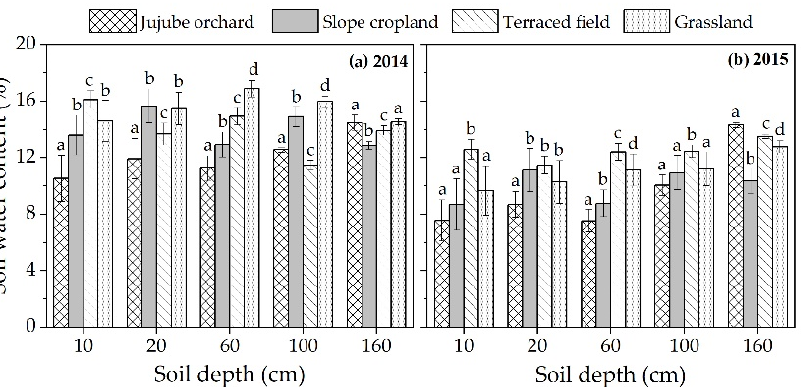
Figure 4. Vertical distribution of average soil water in different land uses during the growing seasons of 2014 ( a ) and 2015 ( b ). The soil water content for each land use type in the soil profile is the average of the daily mean water content for that soil layer throughout the growing season. Different lowercase letters in the same column represent significant differences between various land types within the same soil depth.